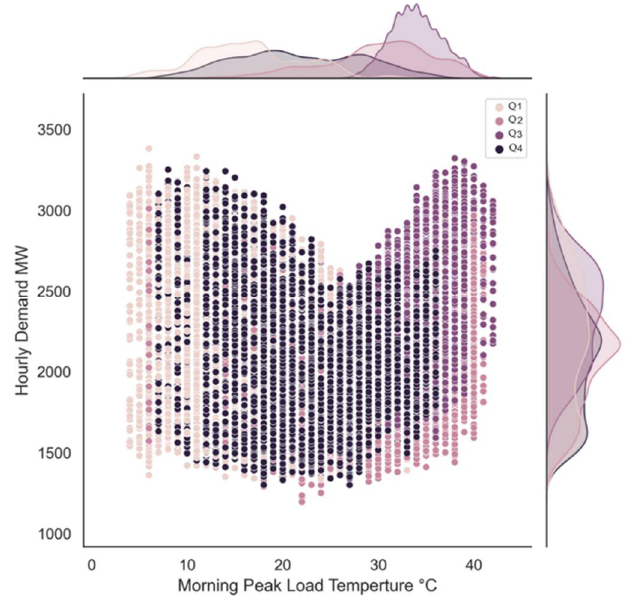
Figure 11. Demand vs. morning peak load temperatures, 2016–2019. Finally, the autocorrelation analysis represents the correlation of the demand at a certain hour to its lagged values shown in Figure 12 indicating which previous hours of the demand hold the highest correlation to be used as predictive features in STLF [21,58].